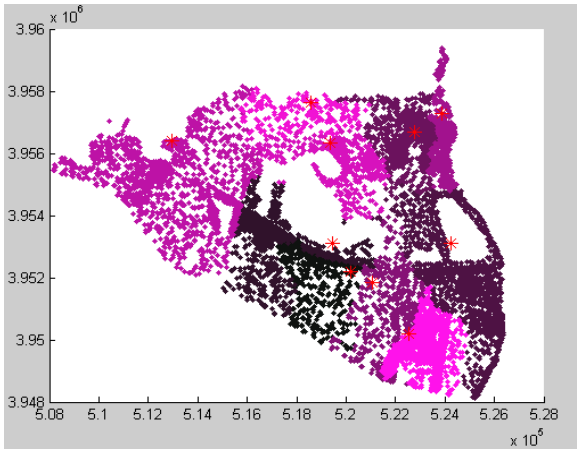
Figure 4. The allocation of each station using the Tabu Search algorithm. Table 1. The number of allocations for each station, runtime, and the optimal value of the function using the Tabu Search